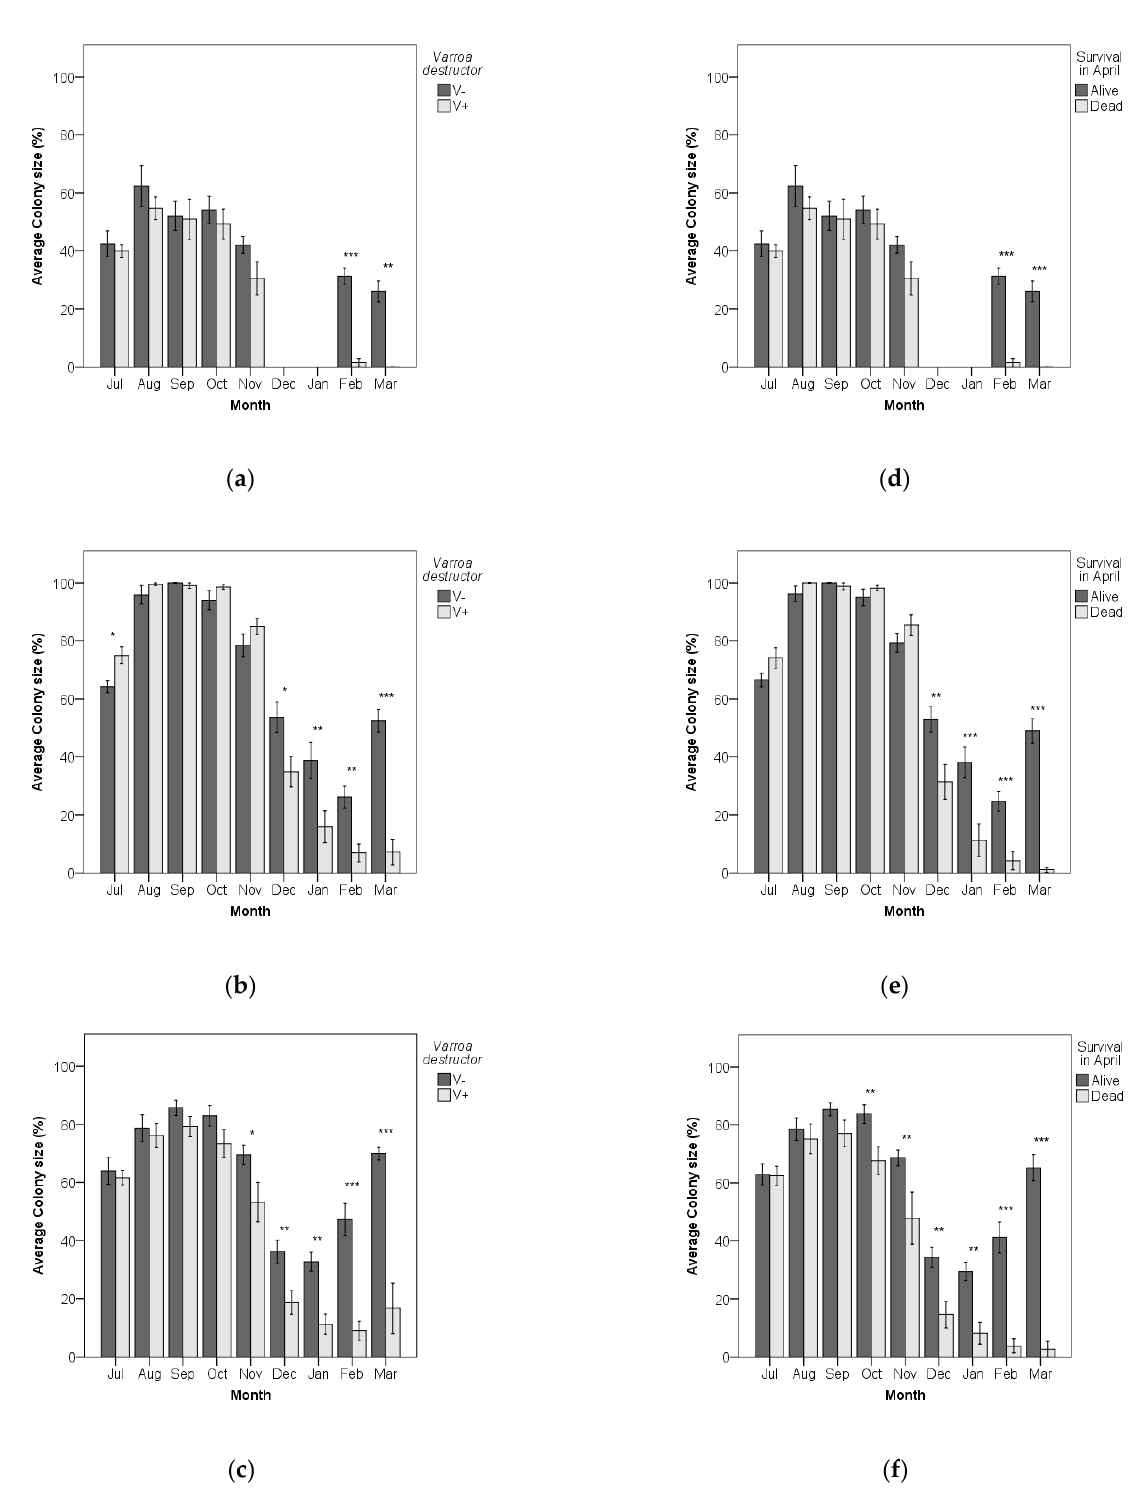
Figure 1. Number of V. destructor mites per gram of bees per month in 2012 ( a ), 2013 ( b ) and 2014 ( c ) for colonies without acaricide treatment (V+, dark grey bars) or with acaricide treatment (V − , light grey bars). Asterisks show differences between V − and V+ (* p < 0.05; ** p < 0.01; *** p < 0.001), where the data for the statistical test were Ln-transformed (+0.0005).